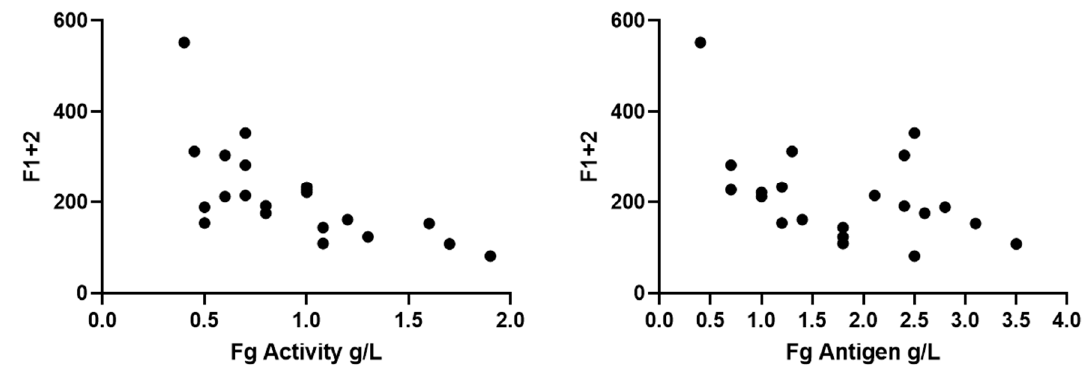
Figure 5. Correlation of F1+2 levels with Fibrinogen activity and antigen. Data are shown for 20 patients as follows: asymptomatic n = 13; bleeding n = 5, thrombosis n = 2; hypofibrinogenemia n = 9; dysfibrinogenemia n = 8 and hypodysfibrinogenemia n = 3.